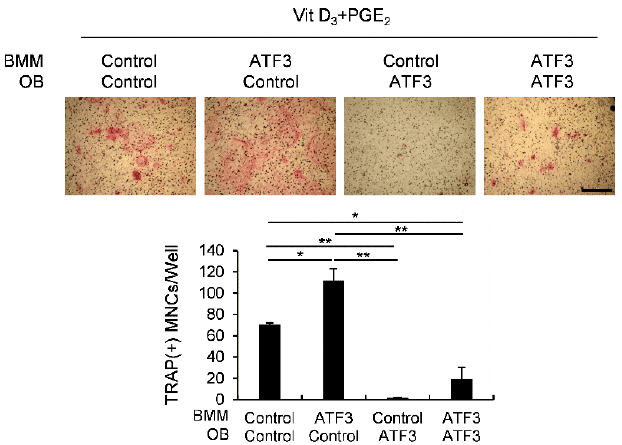
Figure 3. Osteoblastic ATF3 exhibits precedence over pro-osteoclastic function of ATF3 in BMMs. Primary osteoblast precursors and BMMs transduced with pMX-IRES-EGFP (control) or ATF3 retrovirus were co-cultured in the presence of Vit D 3 and PGE 2 . The cultured cells were stained for TRAP (upper panel). TRAP-positive multinucleated cells were quantified (lower panel), scale bar: 200 µ m. * p < 0.01, ** p < 0.001 vs. control.